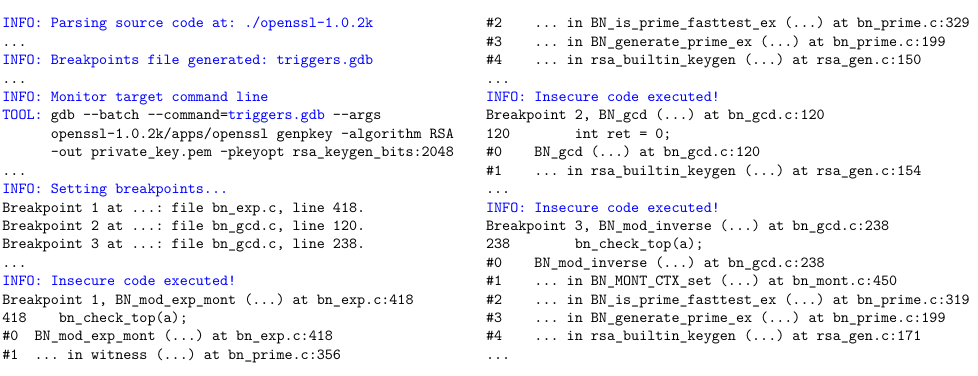
Figure 2: Testing the proposed methodology